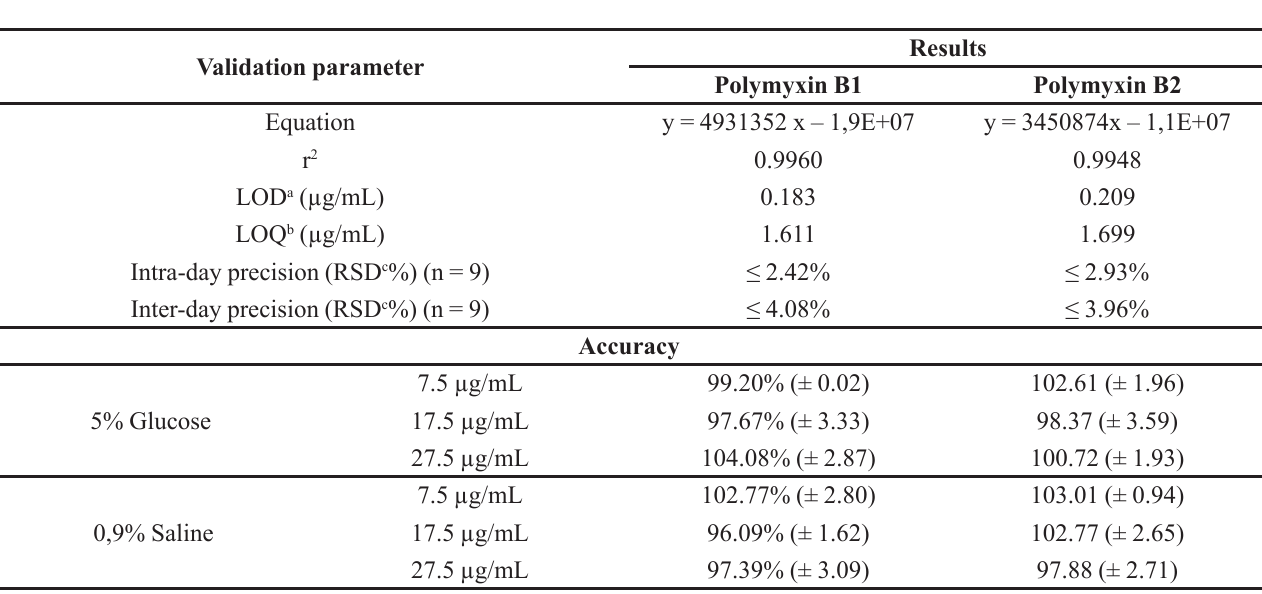
TABLE I ‑ Results of analytical method validation Validation parameter